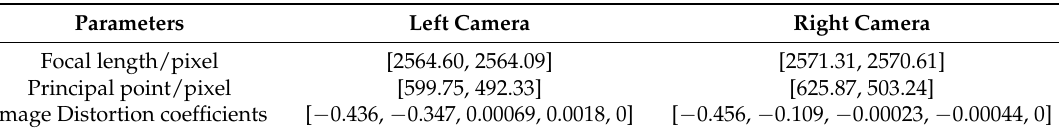
Table 3. Intrinsic parameters of the two